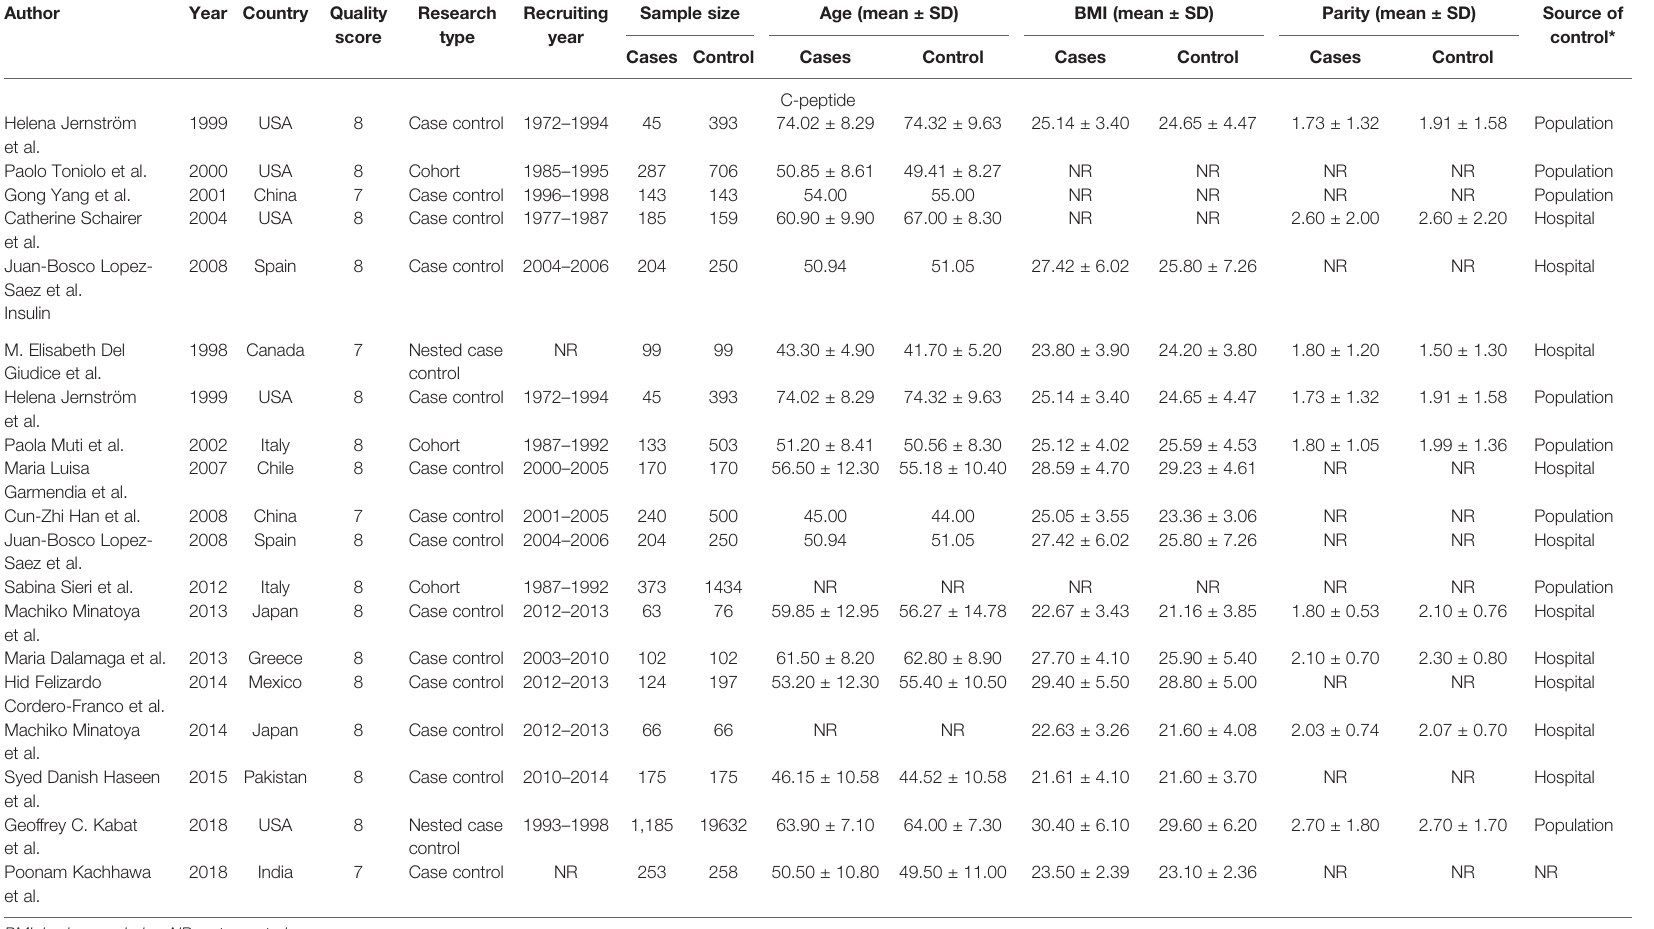
TABLE 1 | Characteristics of studies included in the